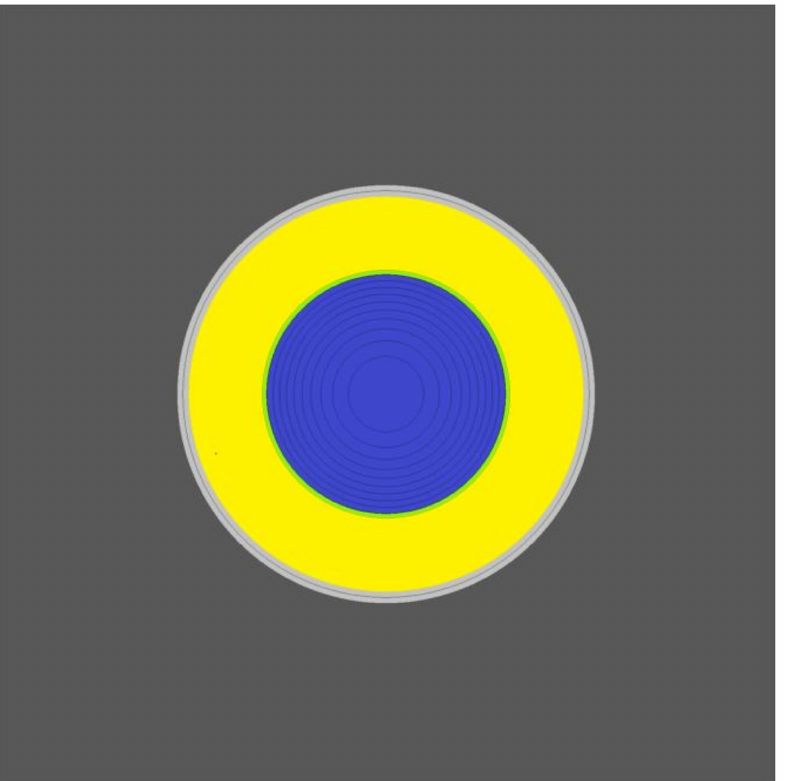
Figure 3. 2D SCALE/POLARIS model (molten salt fuel core—blue, stainless steel—light green, NaCl reflector—yellow, vacuum—light gray, absorber material—dark gray) used for the general